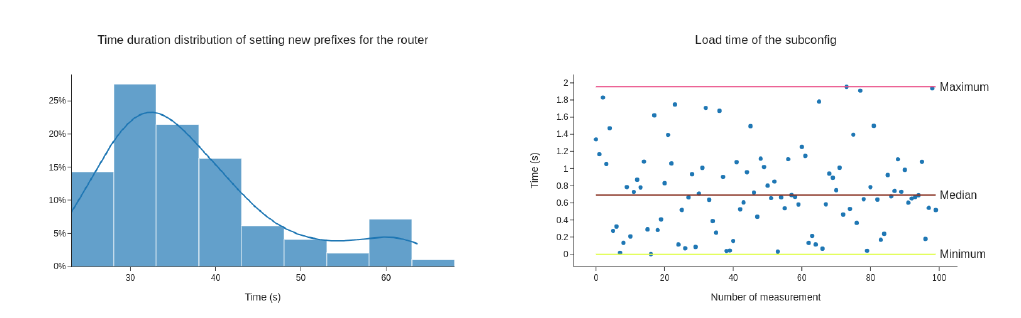
Figure 6. Time duration distribution of setting new prefixes for the router